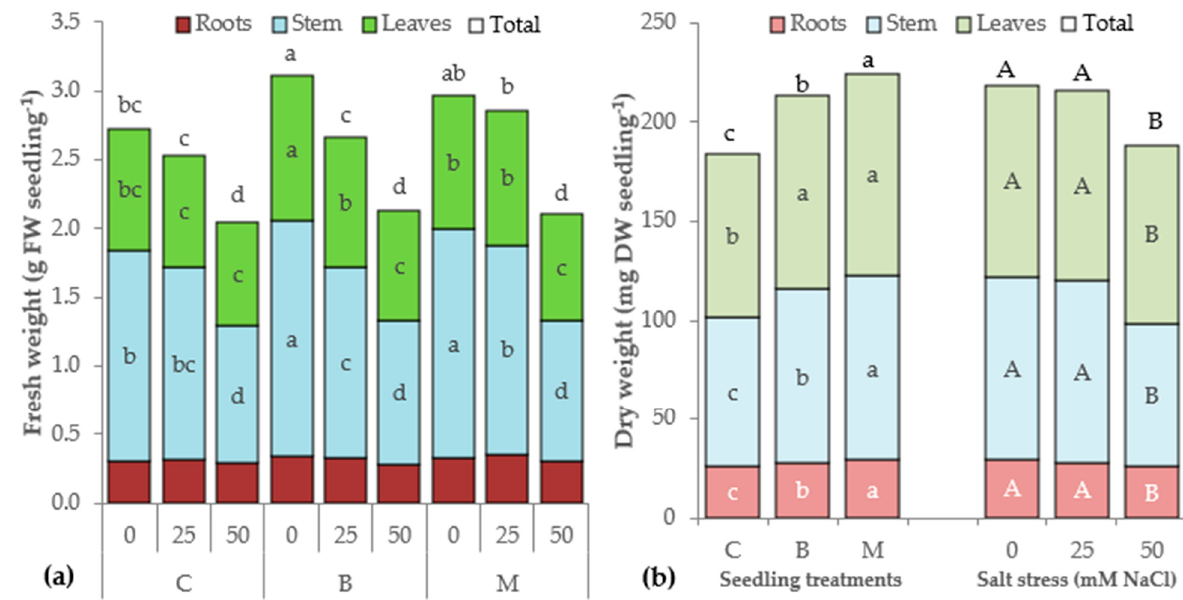
Figure 4. Effect of microbial biostimulant treatments (C, untreated control; B, Bactorr S13 ; M, Flortis Micorrize) and salt stress (0, 25, and 50 mM NaCl in the irrigation water) on the total, root, stem, and leaf ( a ) fresh or ( b ) dry weight of tomato seedlings (bars of the same color with different uppercase or lowercase letters are significantly different at p < 0.05 according to the LSD test).